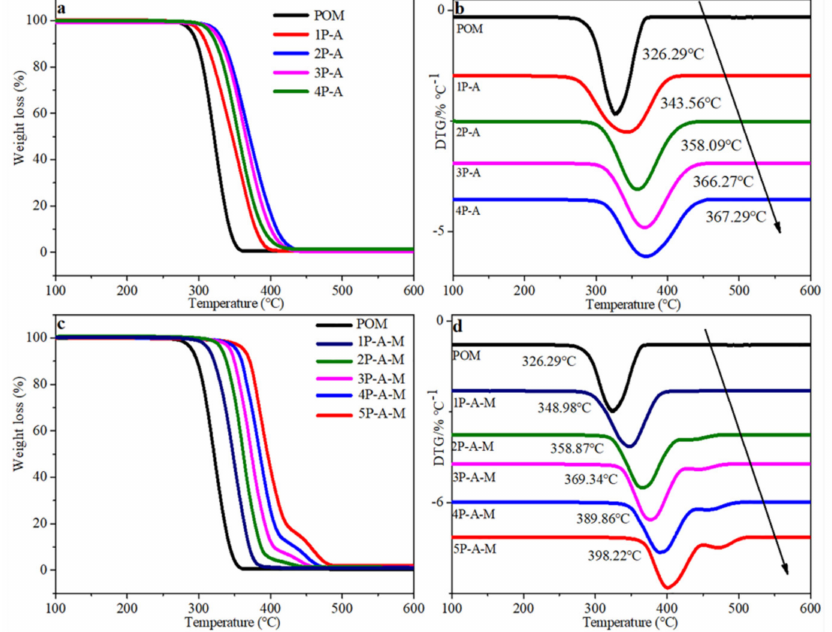
Figure 4. ( a ) TGA and ( b ) DTG diagrams of POM/Ag nanocomposites; ( c ) TGA and ( d ) DTG diagrams of POM/Ag/MAH- g -POE nanocomposites.